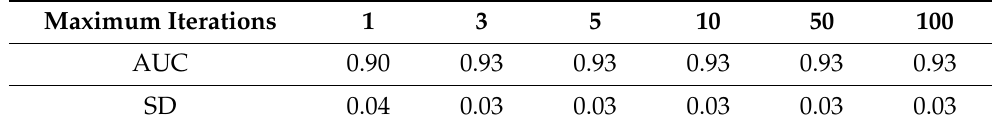
Table 10. Performance of the proposed method (mean AUC and standard deviation) on ECG tensors as the maximum number of iterations varies.